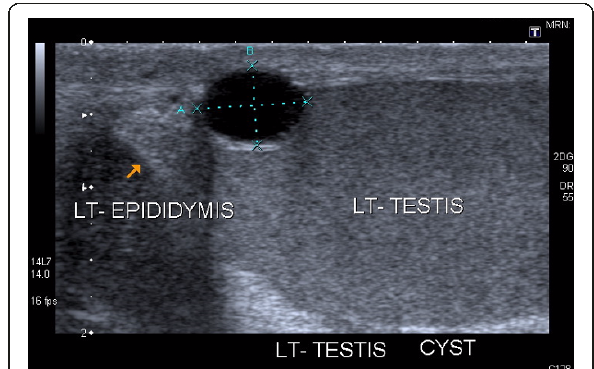
Figure 1 A 7 × 5 mm simple cyst in the upper pole of an otherwise normal testis - well circumscribed, anechoic area with smooth wall and posterior acoustic enhancement .